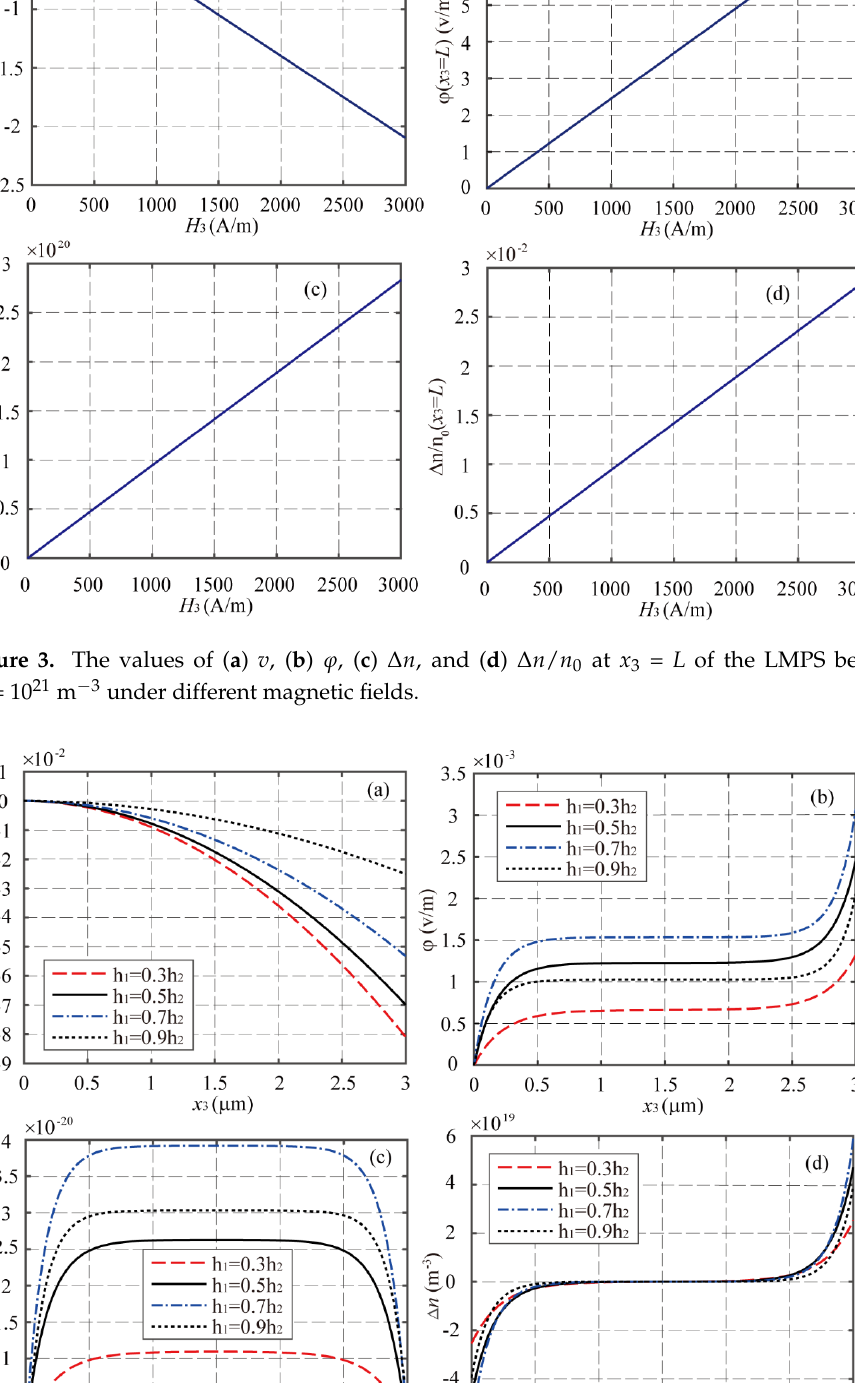
Figure 4. The distributions of ( a ) v , ( b ) φ , ( c ) D , and ( d ) Δ n along the LMPS beam with n 0 = 10 21 m − 3 and H 3 = 1000 A/m for different δ